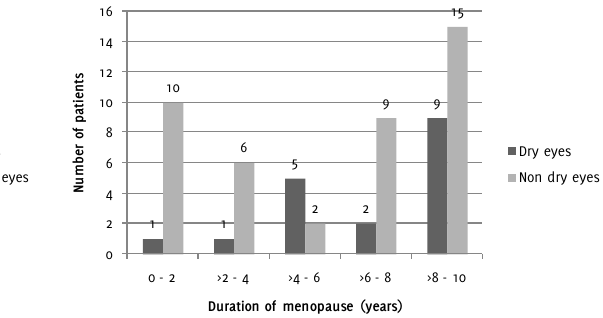
Figure 2. Relationship between duration of menopause in non HRT users with dry eyes. There was no significant association between the occurrence of dry eyes and the duration of menopause. (Pearson correlation test; r=0.174, p=0.15).